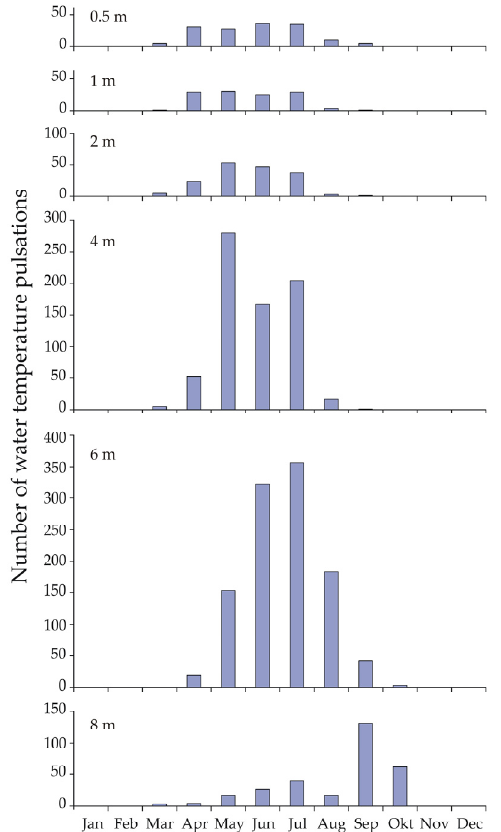
Figure 1. Number of water temperature pulsations ( ≥ 0.5 ◦ C) in hourly intervals in Lake Bachotek in 2006. Based on data from Skowron and Piasecki